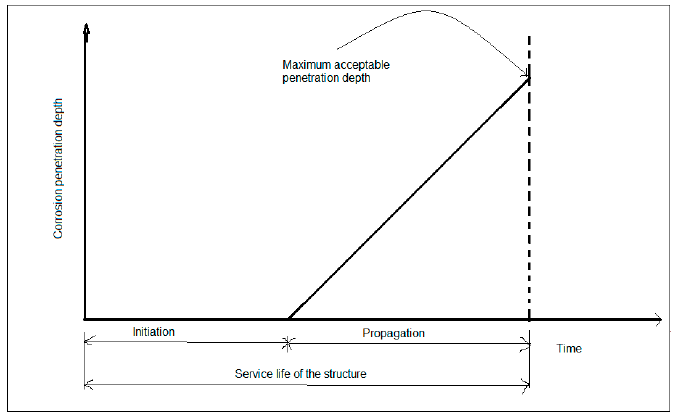
Figure 8. Tuutti’s service life model [91].